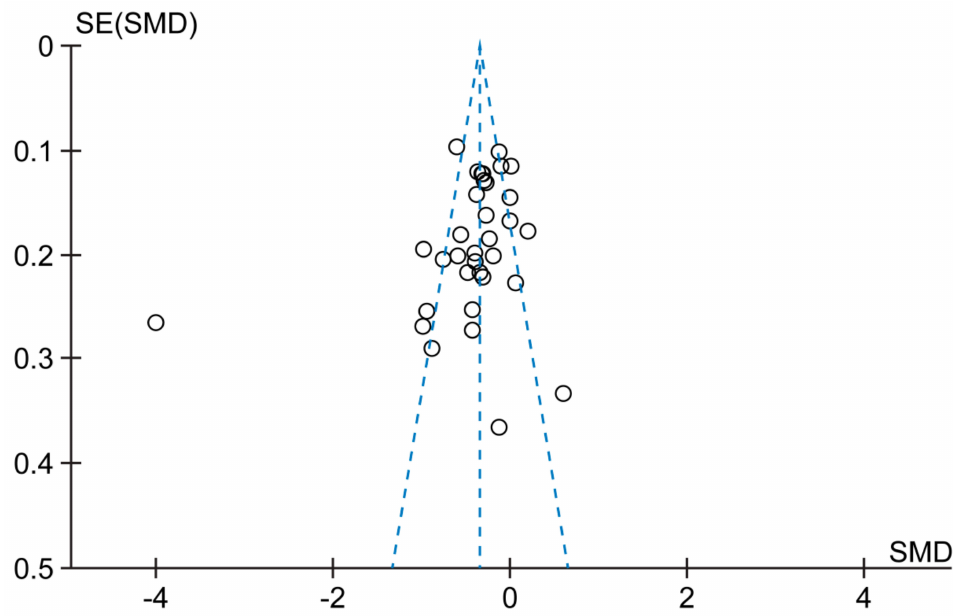
Figure 7. Funnel plot of comparison. SE: Standard Error, SD: standard